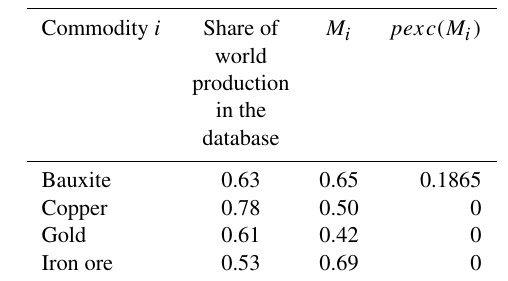
Table 1. Share of global commodity portfolios exposed to wet and dry events. M i is the maximum share of production exposed ob- served over 114 years, and pexc(M i ) refers to the probability that this level of exposure or higher could occur across the different min- ing sites if the climate risks were not spatially